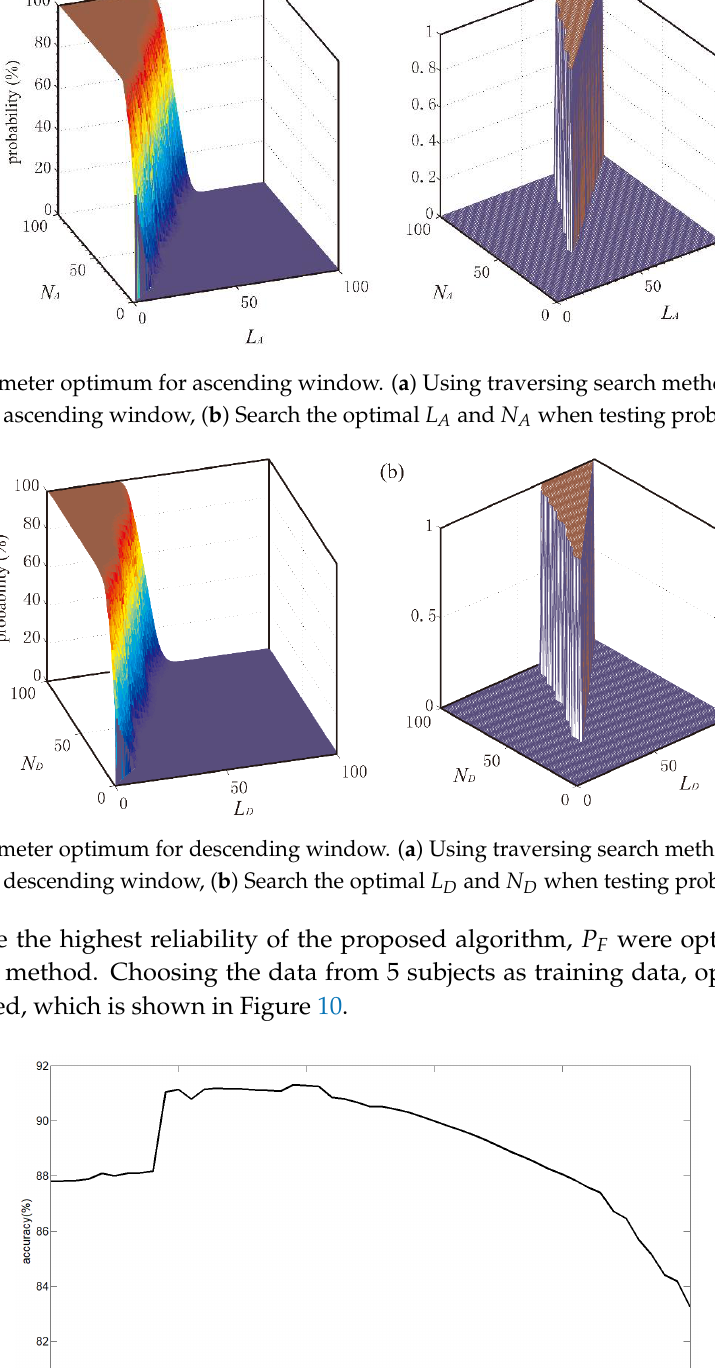
Figure 10. Parameter optimum for P F .